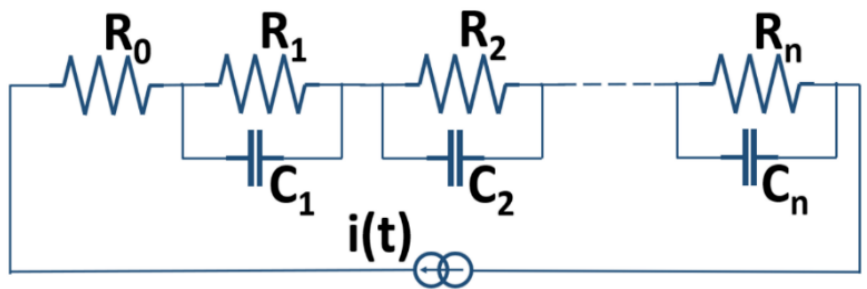
Figure 5. Modelling electrochemical cell using an array of Voigt elements plus a single resistor.